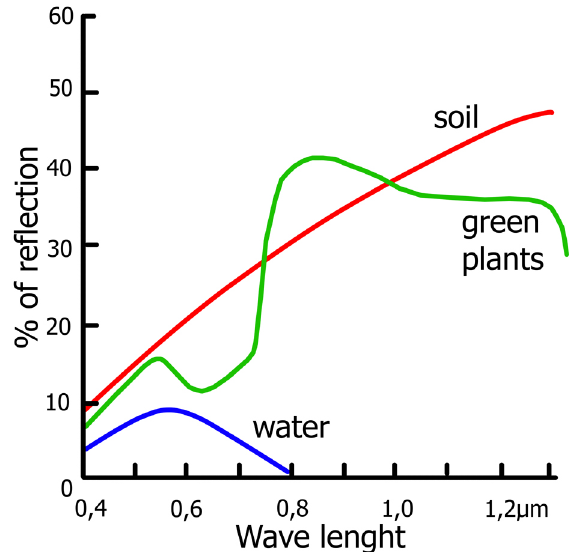
Fig. 1. Standard spectral reflection curves of soil (red), vegetation (green) and water (blue) (Zawiła- Niedźwiecki